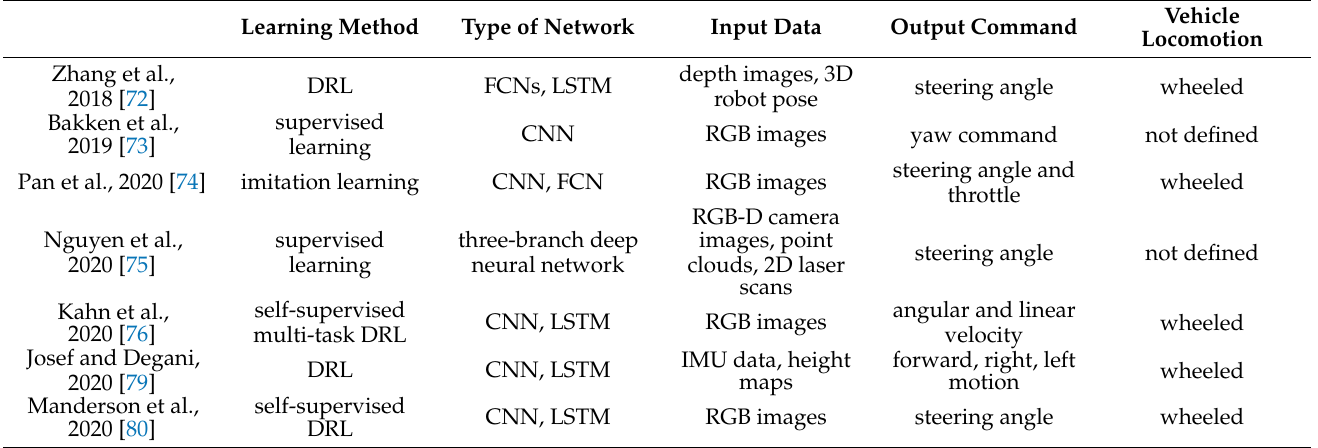
Table 6. Works on end-to-end deep learning based navigation